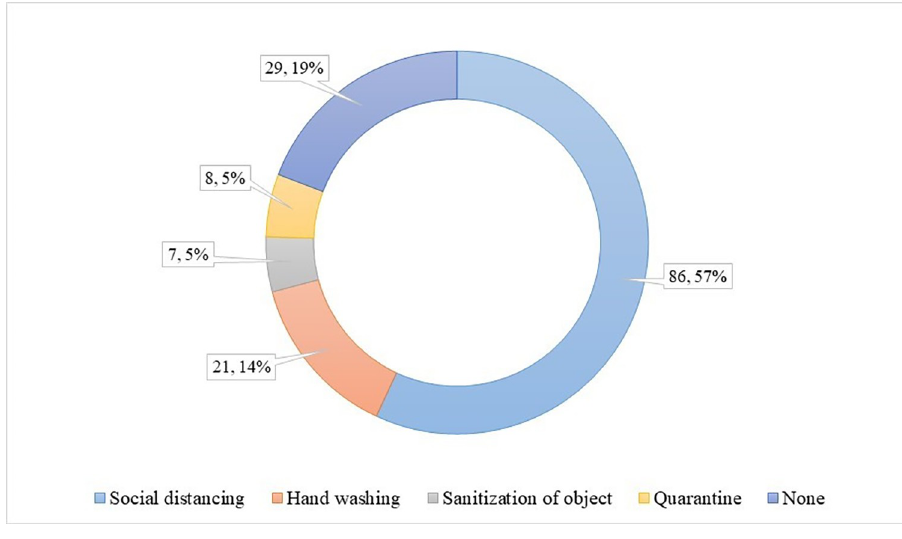
Fig 4. Best alternative to